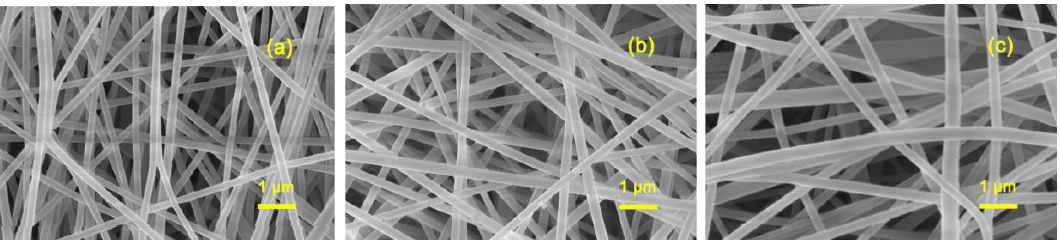
Figure 3. SEM micrographs of n-hemin/PAN with different hemin mass fractions: ( a ) 0.8 mg g −1 ; ( b ) 14.3 mg g −1 , ( c ) 29.1 mg g −1 .